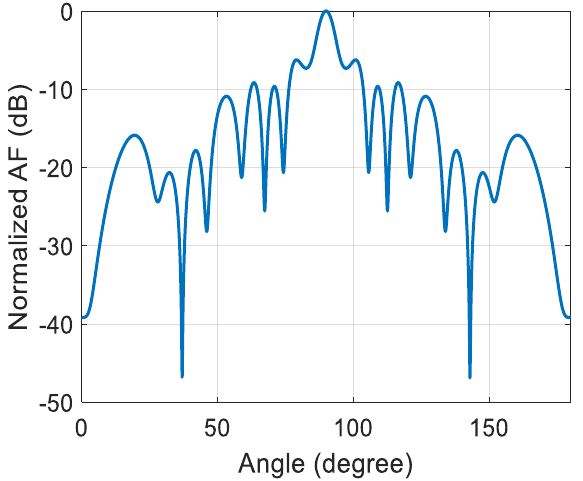
Figure 8. The normalized triangular-shaped array factor for 20 element array antenna by modifying the excitation amplitude of the array antenna using FKE.